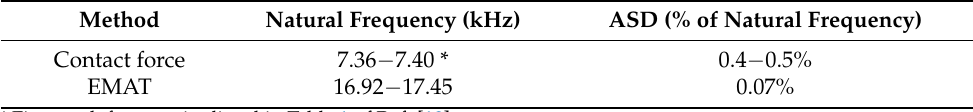
Table 5. Comparison in performance between the contact force [10] and EMAT methods.